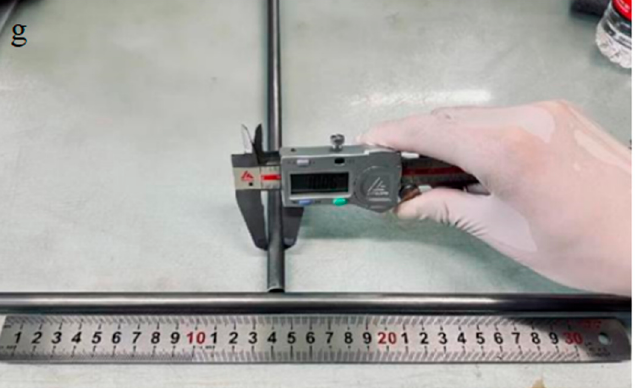
Figure 8. Forged bars and strips made of Al 0.3 CoCrFeNi. ( a – e ) shows the dimensions of strips, ( f , g ) shows the dimensions of bars.